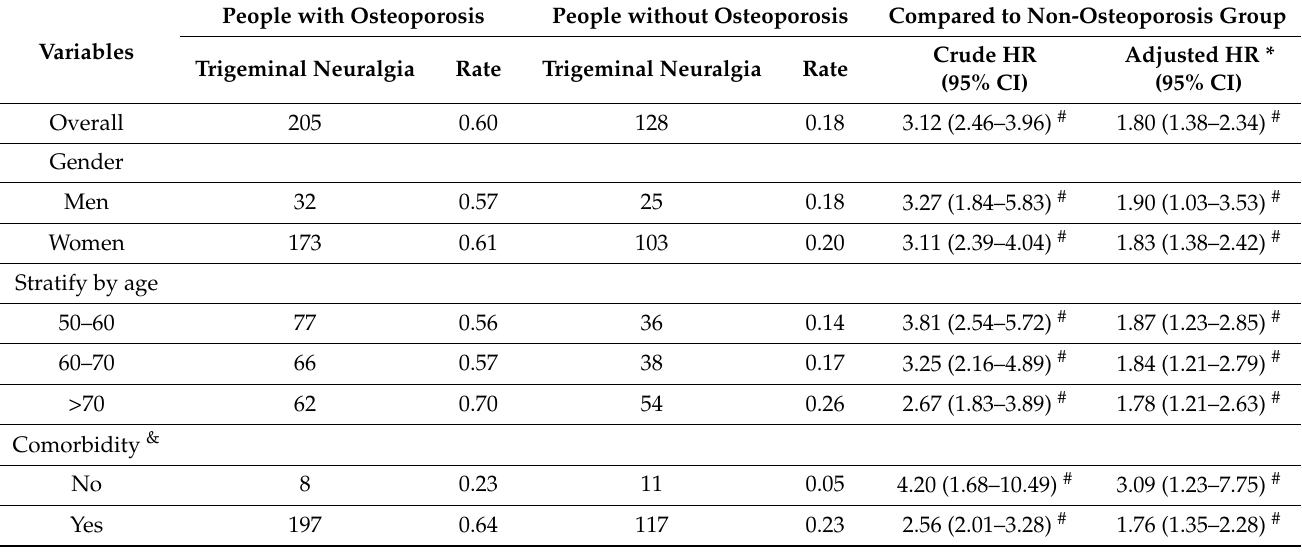
Table 2. Trigeminal neuralgia risk and analyses using demographic characteristics and comorbidity among people with or without osteoporosis.